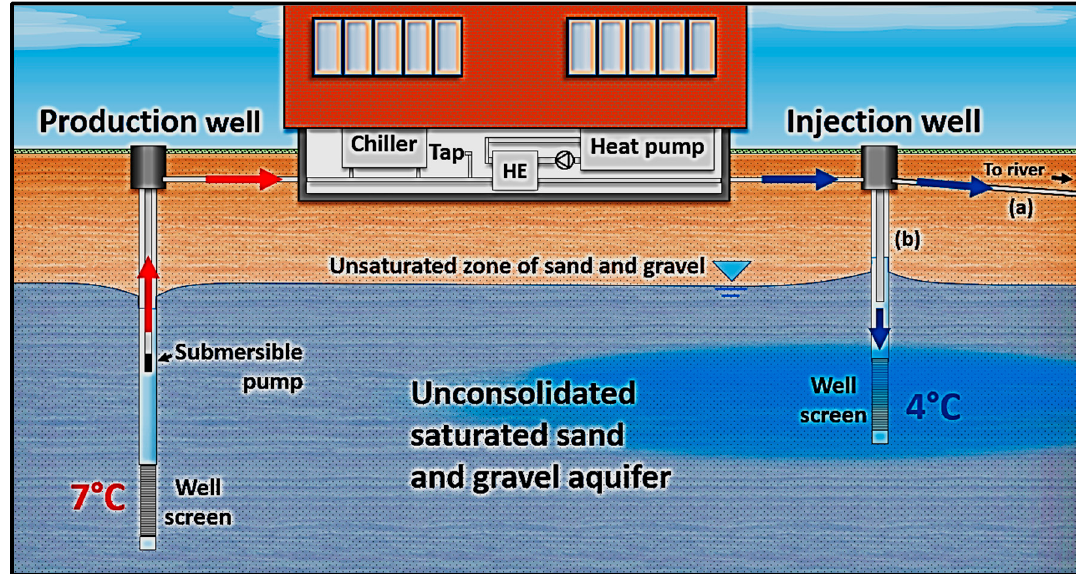
Figure 1. Types of groundwater heat pump (GWHP) systems in Melhus. ( a ) Design solution with run-off to nearby river through the local drainage system. ( b ) Most common design with re-injection of groundwater. A tap in the machinery room allows for water quality sampling.